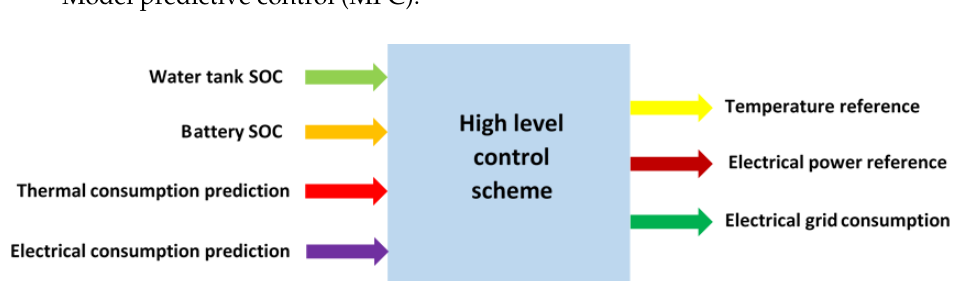
Figure 6. Control scheme for the CHP